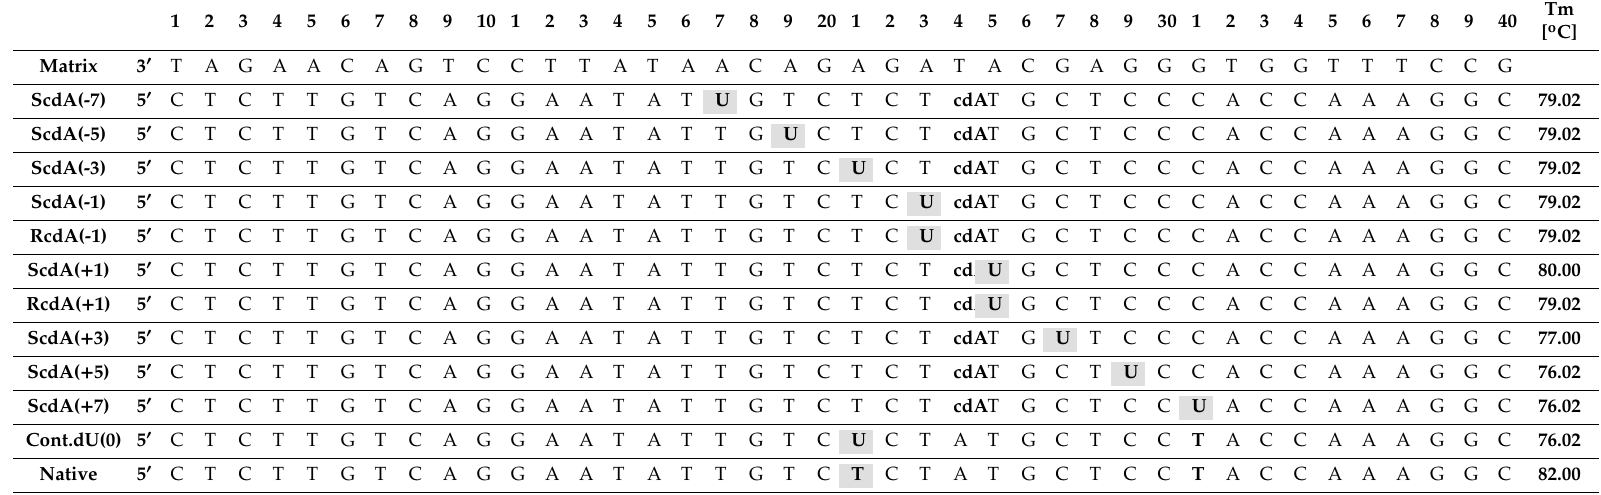
Table 1. Sequence of oligonucleotides containing 2 (cid:48) -deoxyuridine and 5 (cid:48) ,8-cyclo-2 (cid:48) -deoxyadenosine and thermal stability (Tm) of corresponding